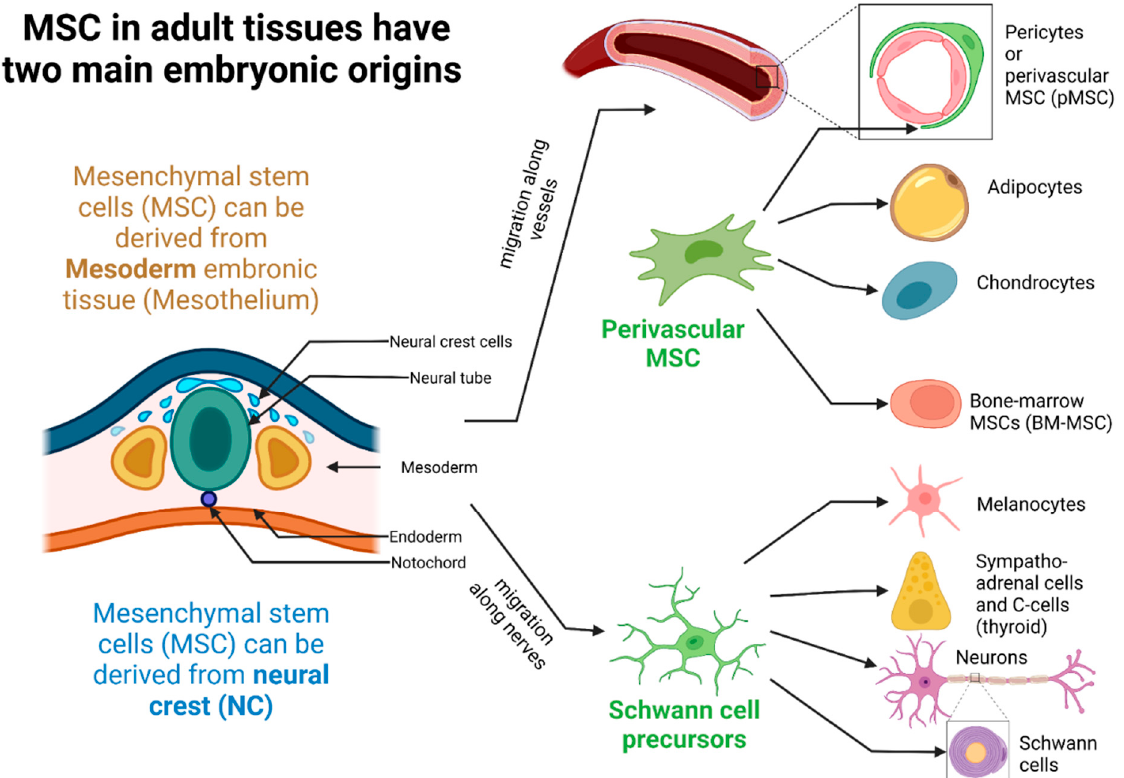
Figure 2. MSC originate essentially from the mesoderm or the ectoderm (neural crest-NC) embryonic tissues. Differentiated MSC notably of the NC are known to contribute to the peripheral nervous system (and the myelin-forming Schwann cells). They also contribute to important regulatory activities in response to environmental stress and for example to protect the skin from the toxic UV irradiation (role of melanocytes producing melanin pigment to protect keratinocytes). A pool of MSC from either the mesoderm or NC will migrate along blood vessels and will remain associated to endothelial cells later in life. These perivascular MSC form for instance the so-called bone-marrow stem cell niche but they are also the main gatekeepers in all major organs in adults. MSC (at least in culture) are known to differentiate into adipocytes, osteoblasts, or chondrocytes. This differentiation potential has been linked to different pathological settings whereby MSC may be involved either in tissue fibrosis (MSC differentiating into collagen-high producing myofibroblasts), in vessel calcification (osteoblast-like cells) or in fat-high producer adipocyte-like cells involved in atherosclerosis. MSC contribute to the tumor microenvironment while differentiating into cancer- associated fibroblasts